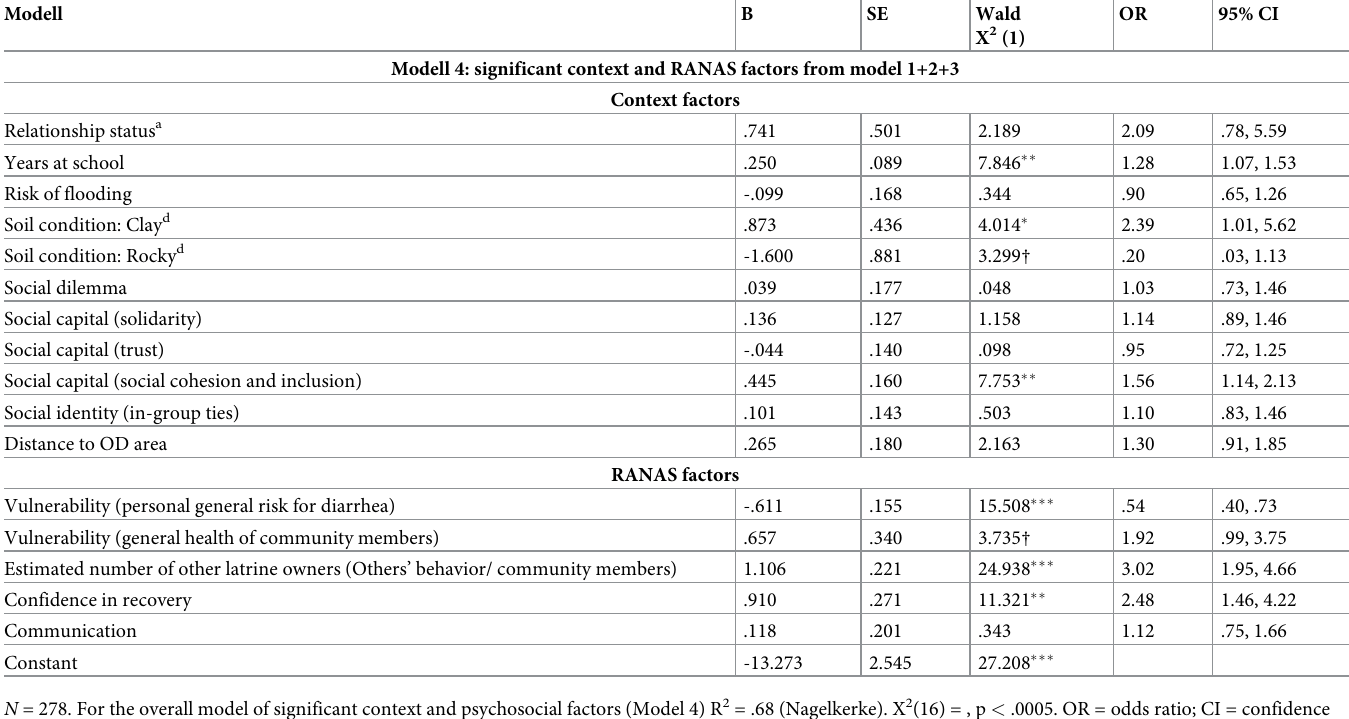
Table 3. Predictors of latrine rebuilding in logistic regression